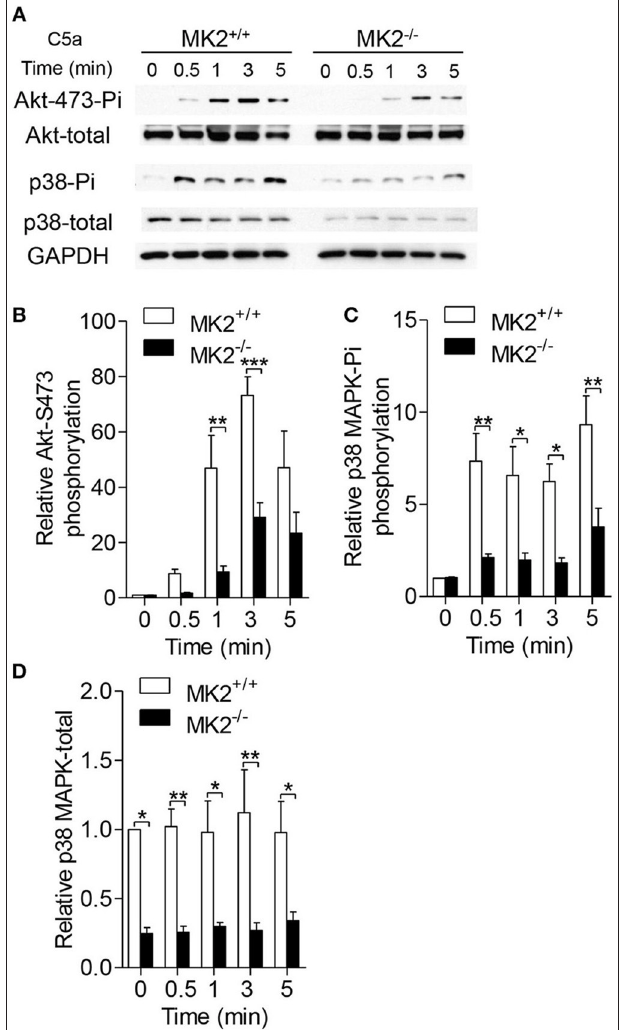
FIGURE 4 | MK2 was required for AKT and p38 MAPK phosphorylation in neutrophils. (A) Neutrophils from MK2 + / + and MK2 − / − mice were challenged with C5a (100nM) for indicated time. Phosphorylation of AKT (Ser473) and p38 MAPK was determined by western blotting using anti-phospho-antibodies against the phospho-AKT (Ser473), total AKT, phospho-p38 MAPK, and total p38 MAPK. (B–D) Densitometry analysis was conducted to determine the relative level of induced AKT phosphorylation, p38 MAPK phosphorylation, and total p38 MAPK. Data shown are means ± SEM from three independent experiments. * P < 0.05; ** P < 0.01; *** P <